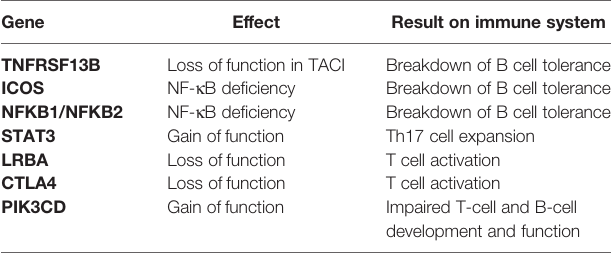
TABLE 2 | Mutations associated with CVID and autoimmunity. Gene